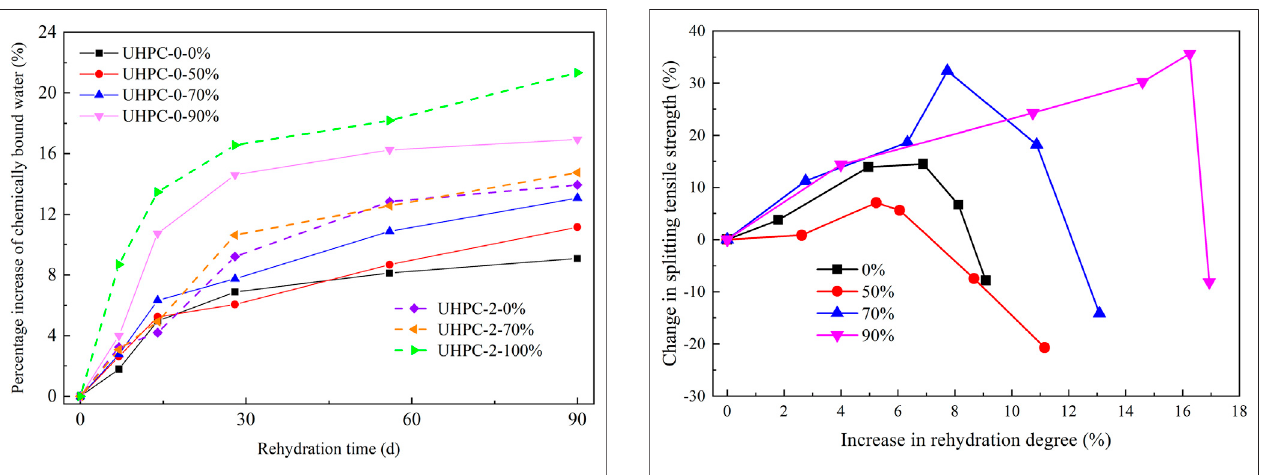
FIGURE 11 | Percentage increase of chemically bound water content of UHPC-0 and UHPC-2 with increasing rehydration time.